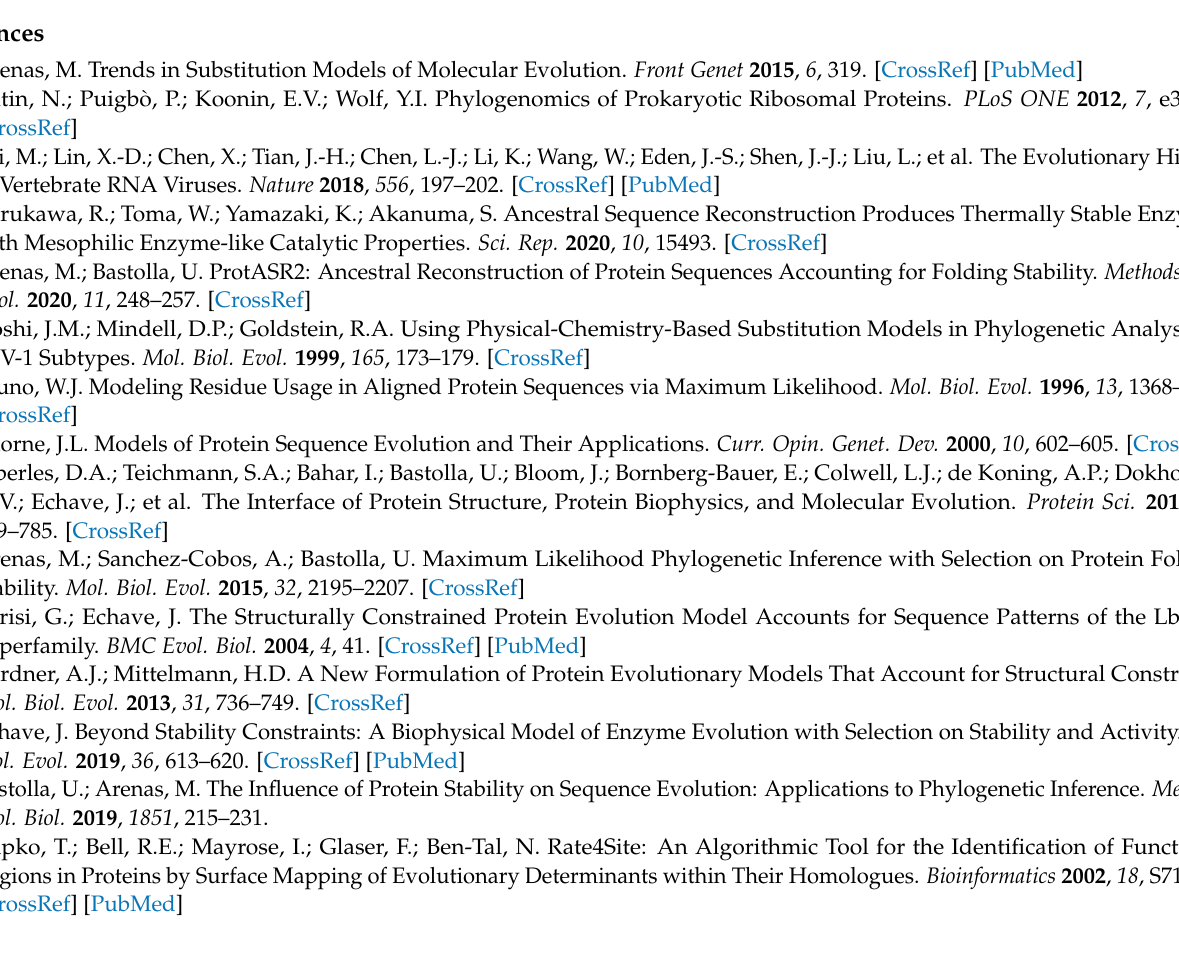
Table S3: Empirical substitution model of HIV IN evolution (HIVin); Table S4: Empirical substitution model of viral IN evolution (VIRin); Figure S1. Comparison of VIRpr and HIVb empirical substitution models concerning their relative substitution rates among amino acids; Figure S2: Comparison of HIVin and HIVb empirical substitution models concerning their relative substitution rates among amino acids; Figure S3: Comparison of VIRin and WAG empirical substitution models concerning their relative substitution rates among amino acids; Figure S4: Likelihood-based evaluation of the HIVin, VIRin and the currently available best-fitting substitution